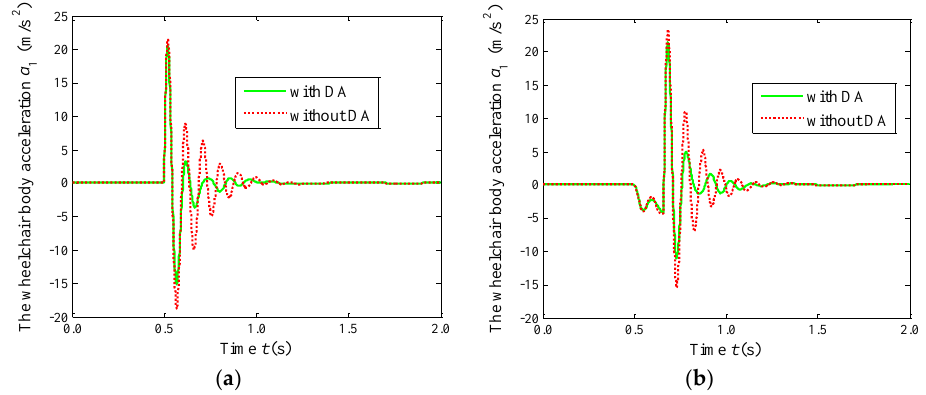
Figure 6. A comparison of the time histories of the wheelchair body acceleration a 1 for the system with the DA and without the DA: ( a ) going up the step; ( b ) going down the step.